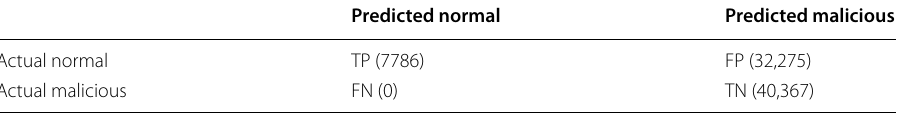
Table 20 Confusion matrix of Naïve Bayes